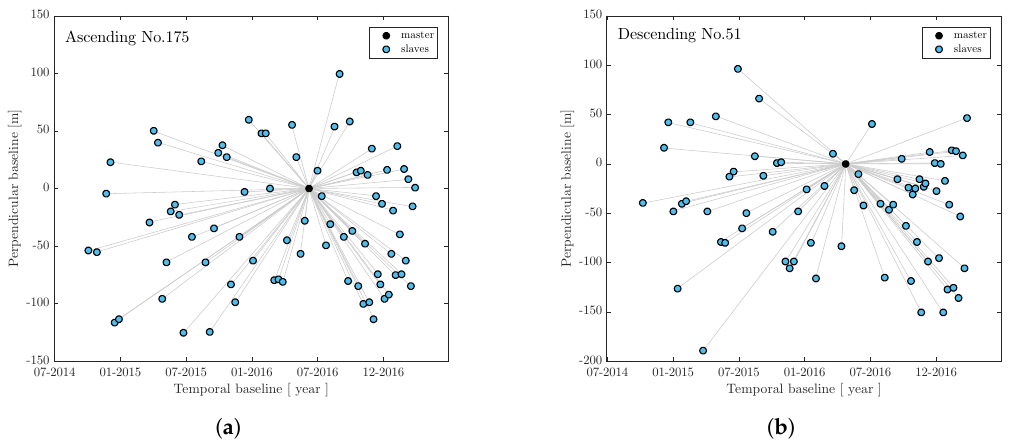
Figure 5. Interferometric combinations of Sentinel-1 SLC images from ( a ) ascending and ( b ) descending